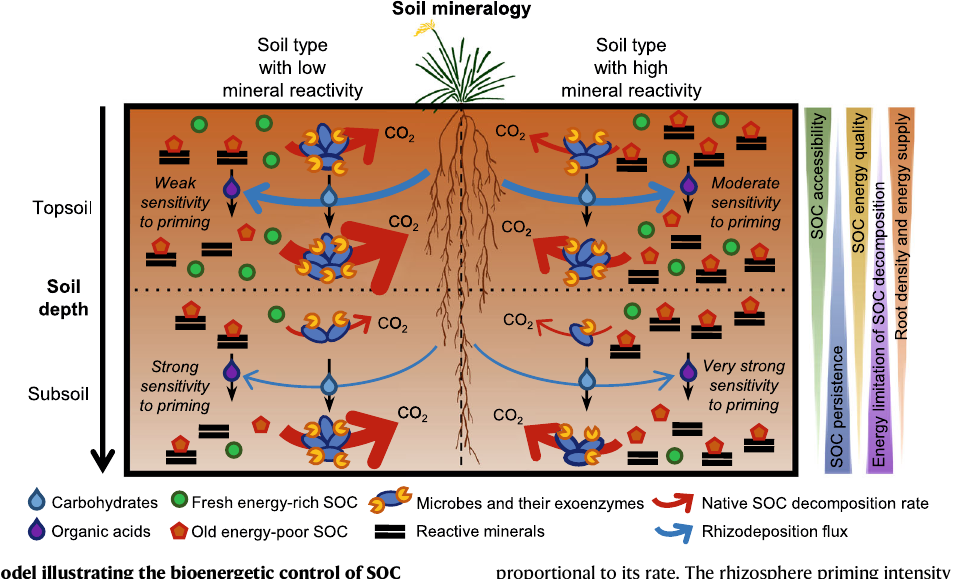
proportional to its rate. The rhizosphere priming intensity represents the magni- tude in the acceleration of native SOC decomposition induced by a given density and energy supply of plant roots. Plant image by Alice